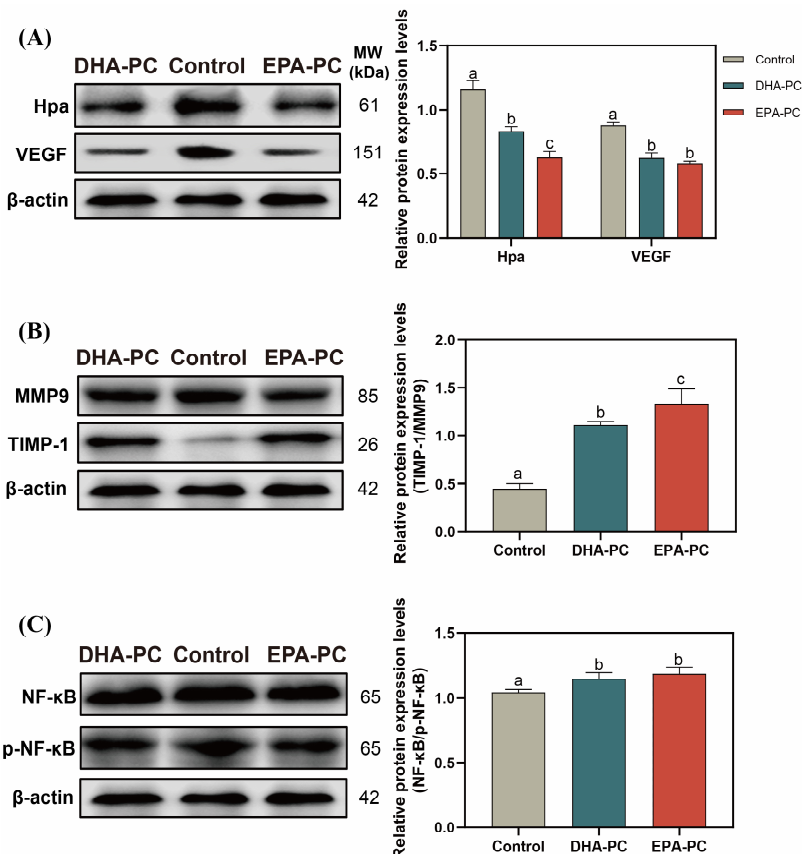
Figure 6. DHA-PC and EPA-PC suppressed protein expression of crucial transcription factors of the invasion and adhesion. ( A ) the expression of Hpa and VEGF. ( B ) the expression of MMP9 and TIMP-1. ( C ) the expression of NF- κ B and p-NF- κ B. Different letters (a, b, and c) indicate remarkable differences at p < 0.05 among all groups determined by ANOVA (Bonferroni’s